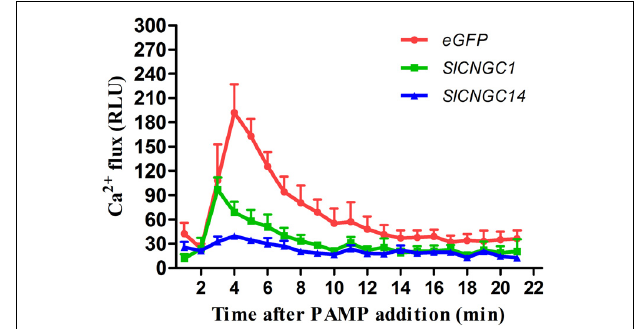
FIGURE 4 | Silencing of SlCNGC1 and SlCNGC14 compromised cytosolic Ca 2 + accumulation. Production of Ca 2 + flux elicited by 100 nM flg22 was detected using a luminescence-based assay in leaf disks of SlCNGC1 -, SlCNGC14 -silenced plants and the eGFP non-silenced control plants of the aequorin transgenic tomato lines. Data are shown as relative luminescence units (RLU) and represent the mean ± SE of three independent experiments.